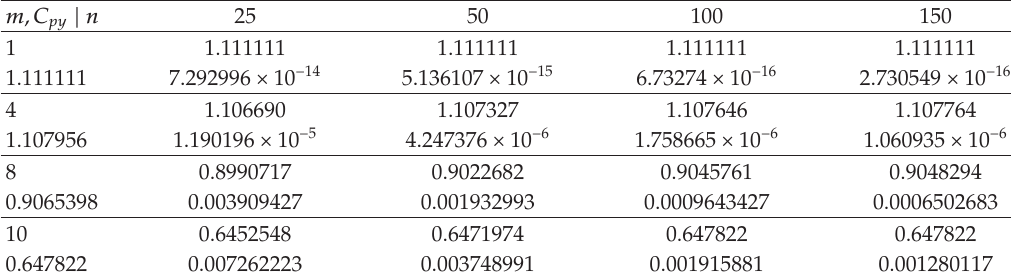
(cid:7) 0, U (cid:7) 8, samples generated from exponential